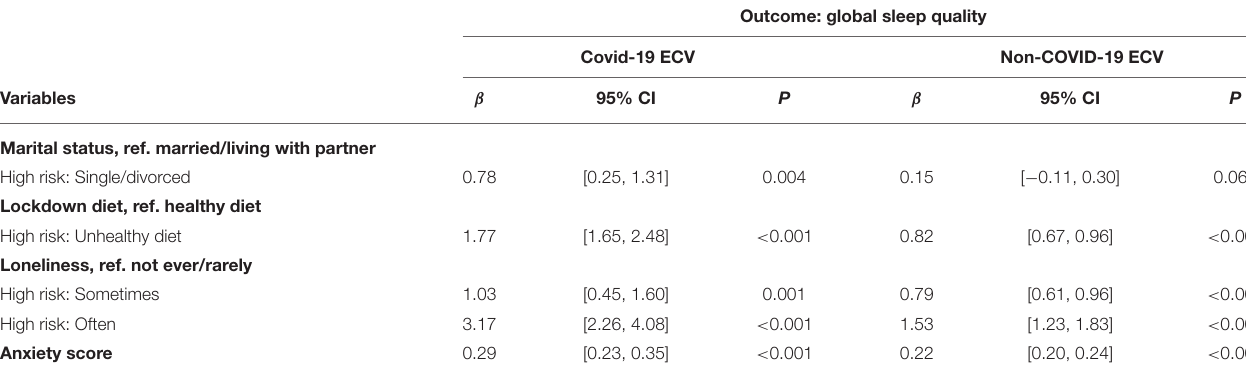
TABLE 3B | Associations of significant moderators of the COVID-19ECV status—sleep quality relationship, among the COVID-19ECV